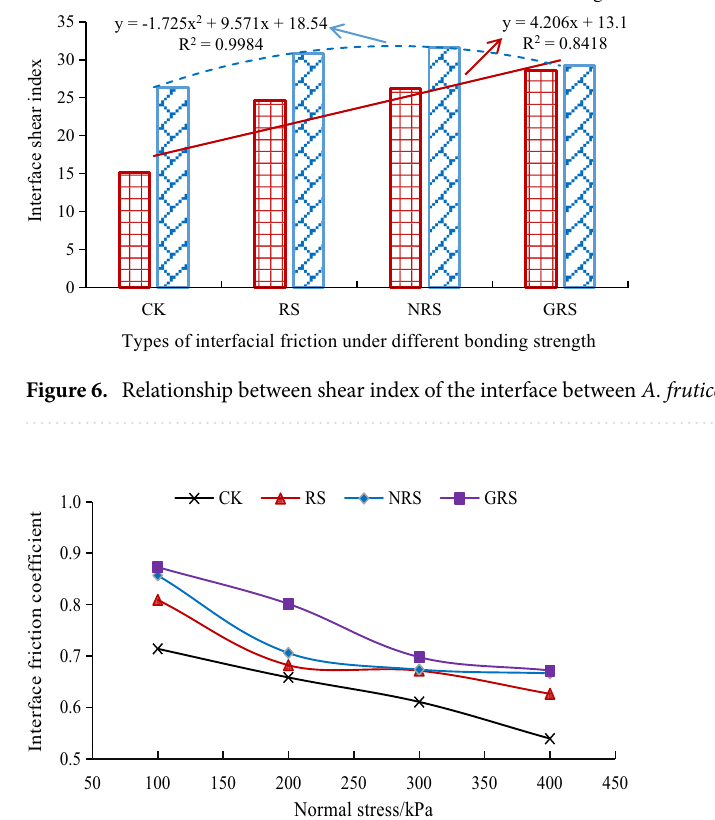
Figure 7. Variation curve of root–soil interface friction coefficient.